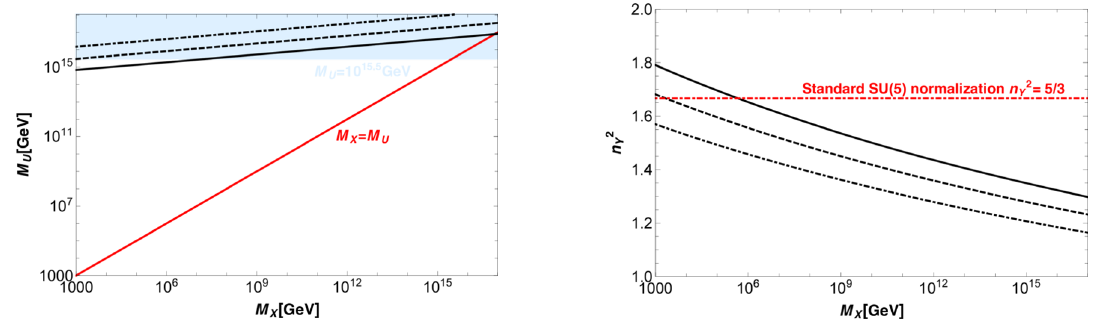
Figure 3 . (Left) unification scale M U as a function of the 3-3-1-1 symmetry breaking scale M X , for three benchmark choices M (dot-dashed curve). (Right) hypercharge normalization n 2 benchmark choices as the left panel.